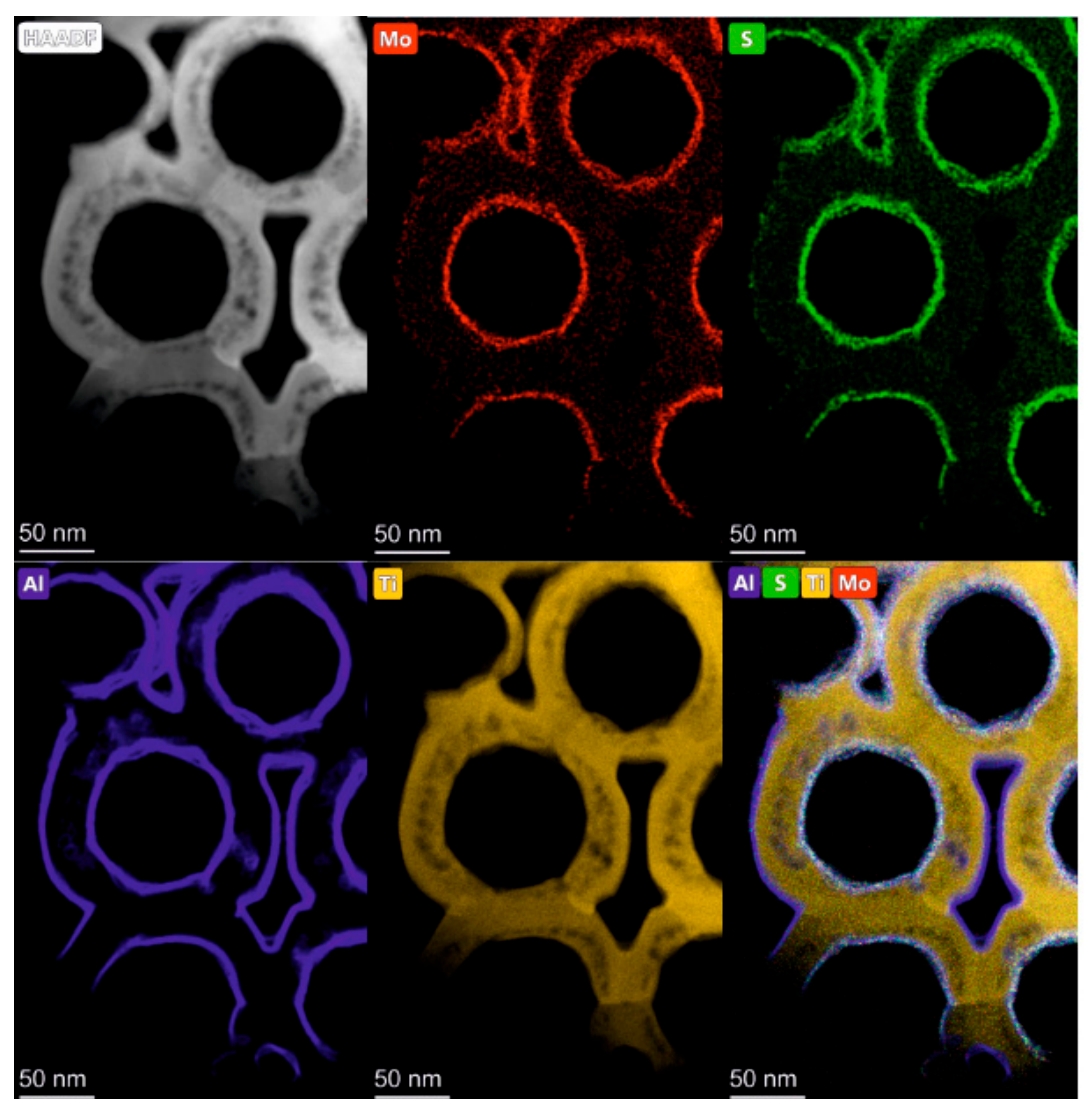
Figure 1. STEM-HAADF image in high magnification and the STEM EDX elemental maps showing the distribution of Mo, S, and Al on the surface of the TiO 2 nanotube layers (TNTs). XPS survey spectra of TNT layers decorated with 15 cycles MoS 2 and with 9 cycles Al 2 O 3 —15